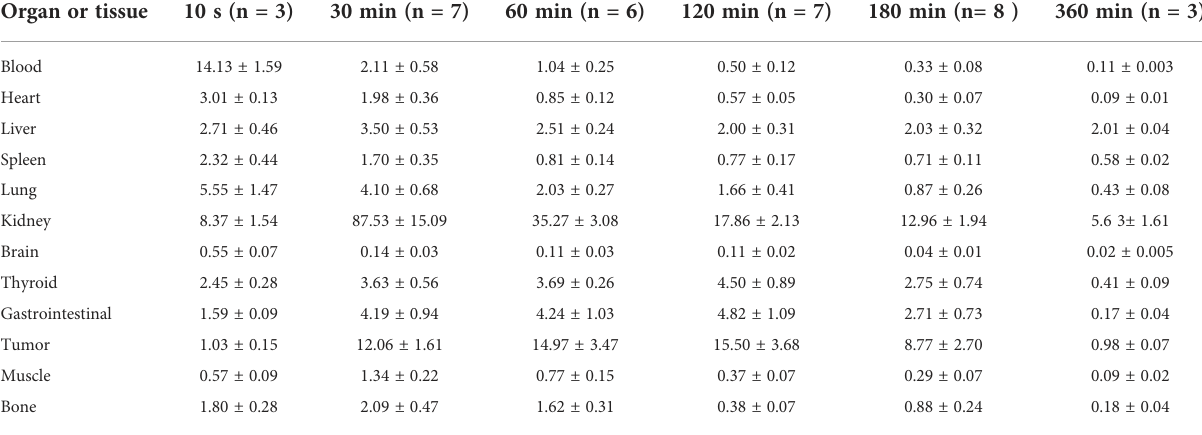
TABLE 1 Biodistribution of 99m Tc-labeled PD-L1 af fi body molecular probe in MC38-B7H1 xenograft-bearing mice (%ID/g, x ± s). Organ or tissue